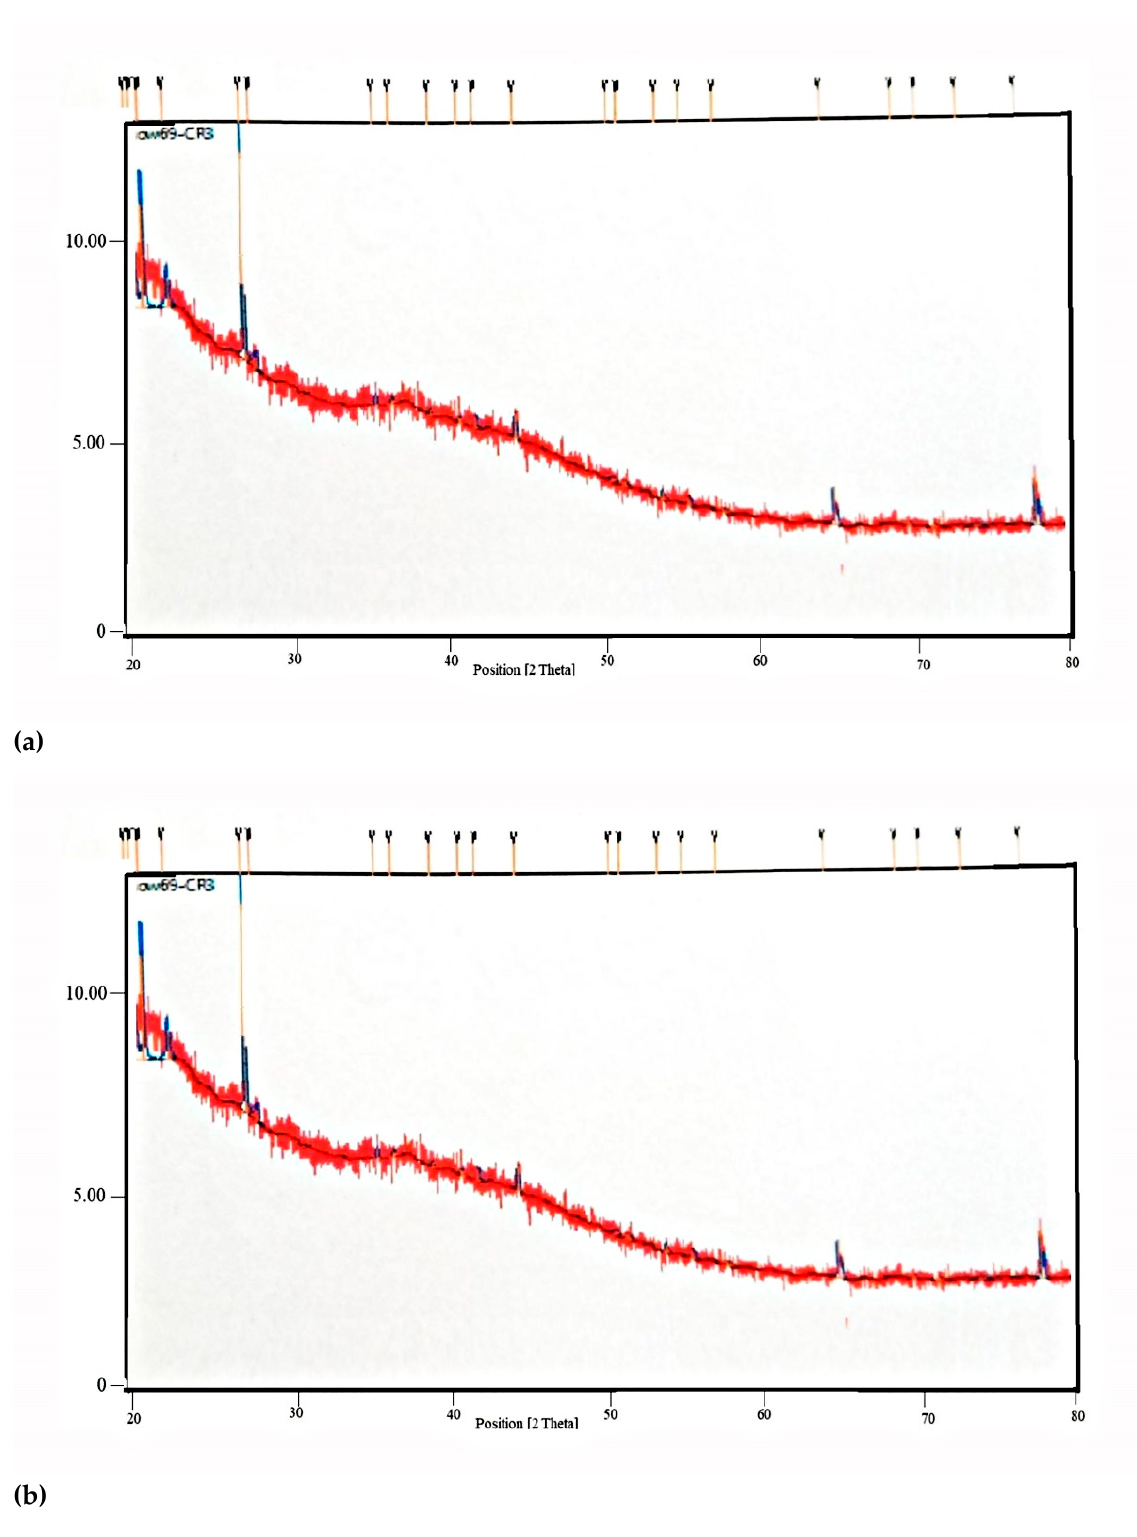
Figure 4. X-ray diffraction (XRD) of ( a ) Plain mixture and ( b ) TRM of gum acacia and gum karaya.